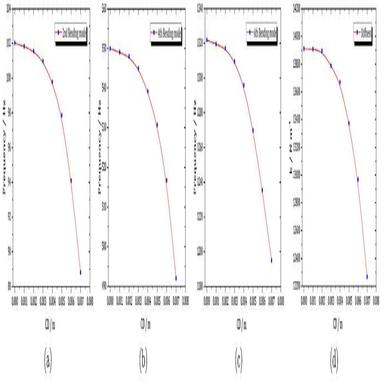
Frequency changes with respect to the crack depth for the (a) 2nd, (b) 4th and (c) 6th bending modes of the cantilever beam. (d) Reduction of the CB stiffness with the crack depth.